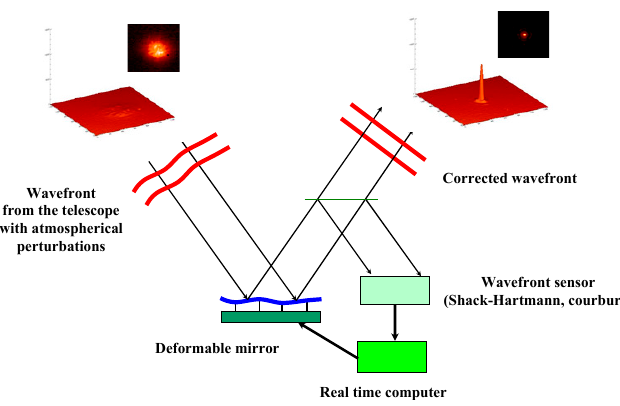
Figure 1. Schematic of a wavefront correction system.